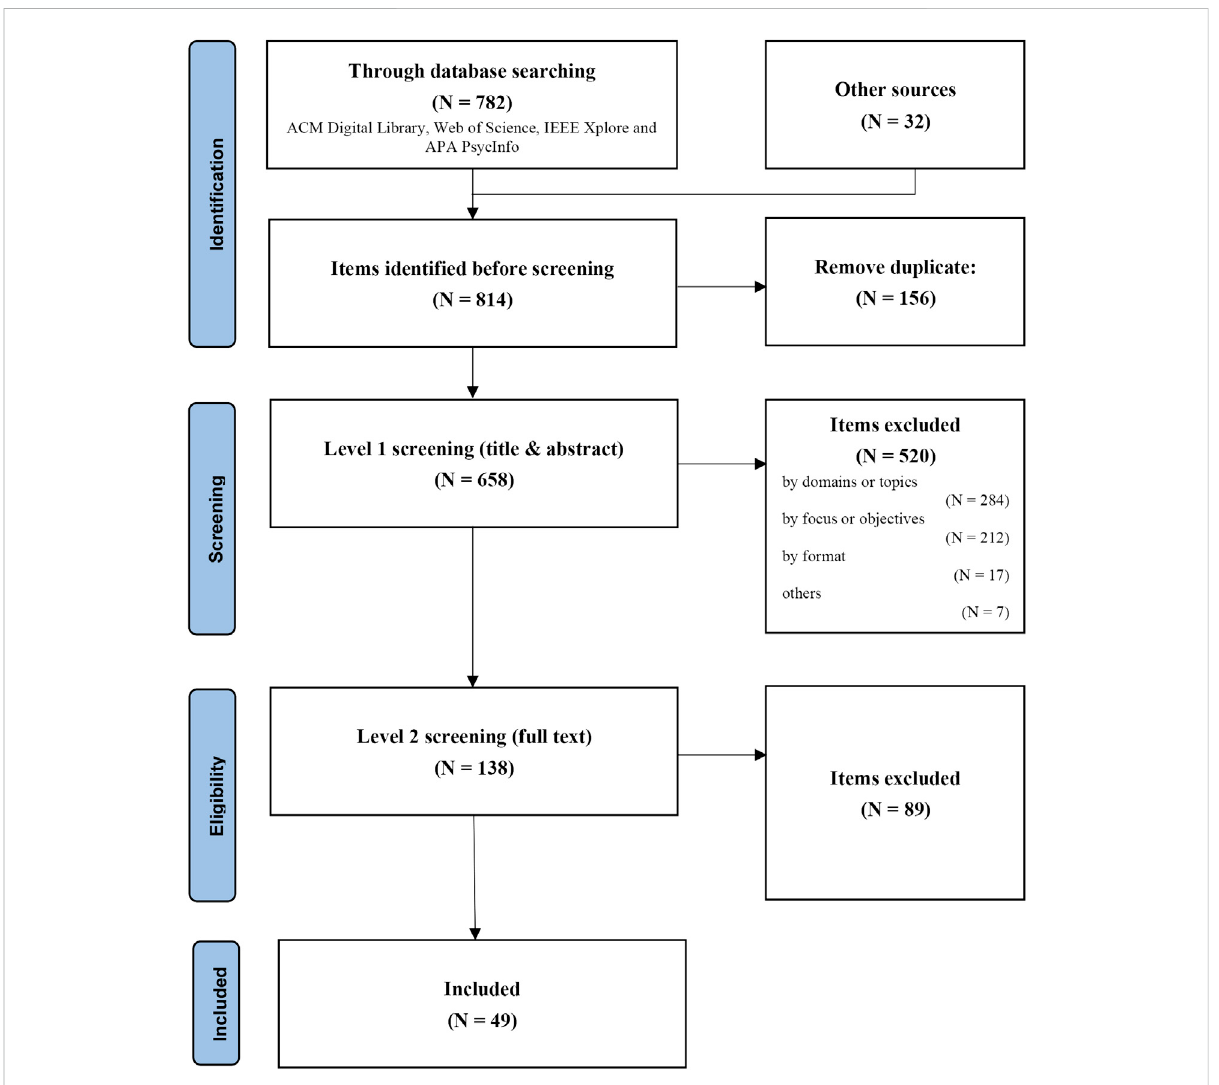
FIGURE 2 Flow diagram of the selection process, numbers of included and excluded items in each